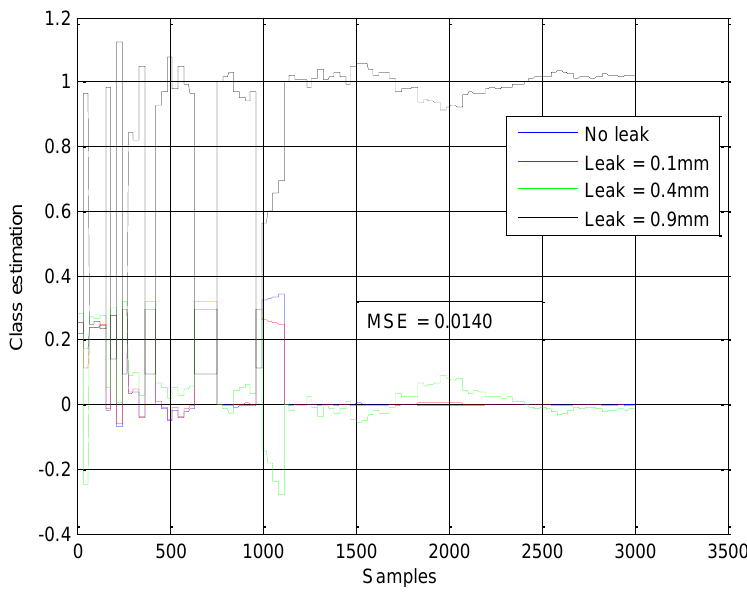
Figure 13. Leak Characterization in “High Leakage”